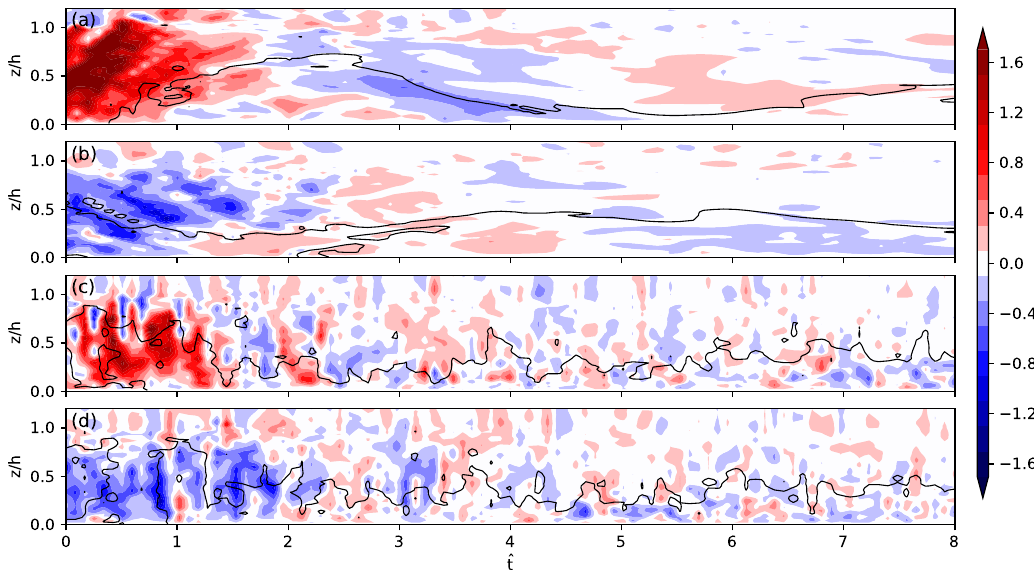
Figure 6. Time series of normalized vertical velocity profiles at ( x , y ) = ( a ) (2.23 km, 6.97 km) and ( b ) (2.23 km, 3.09 km) in the B3 case and the same time series at ( x , y ) = ( c ) (2.23 km, 4.01 km) and ( d ) (2.23 km, 10.11 km) in the S1 case. Contours of 302.75 K and 300.81 K potential temperature are added in ( a , b ) and ( c , d ),